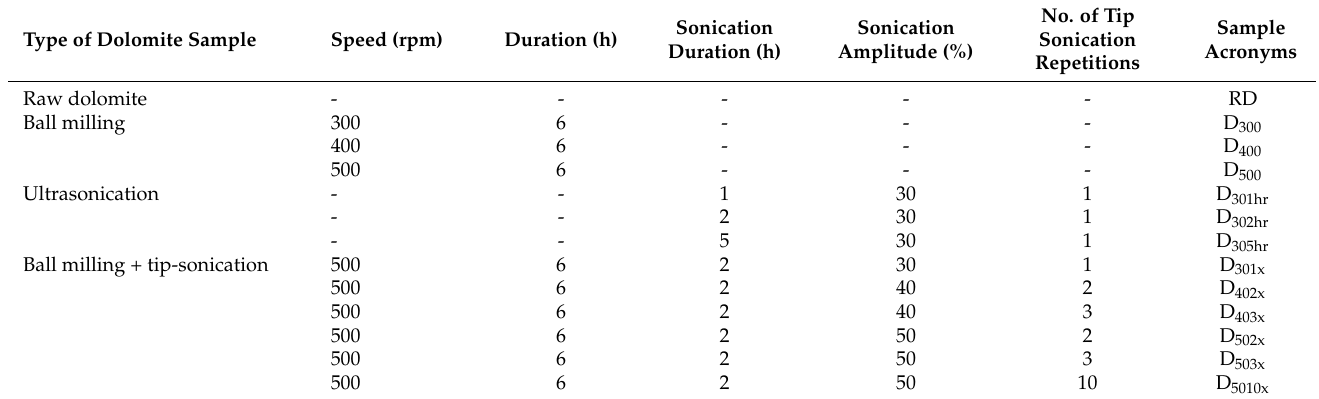
Table 4. Ball-milling and sonication parameters for dolomite samples.